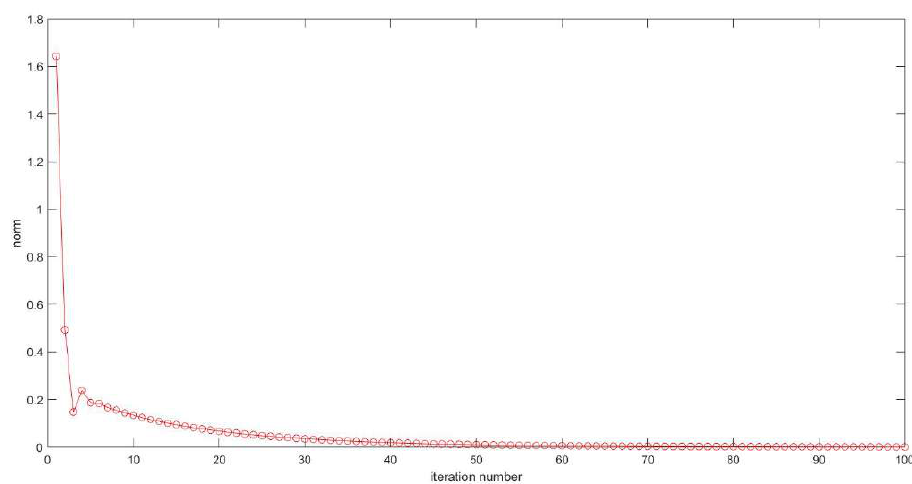
Figure 4. Convergence of norm of solution u of (21)–(23) under control to zero.